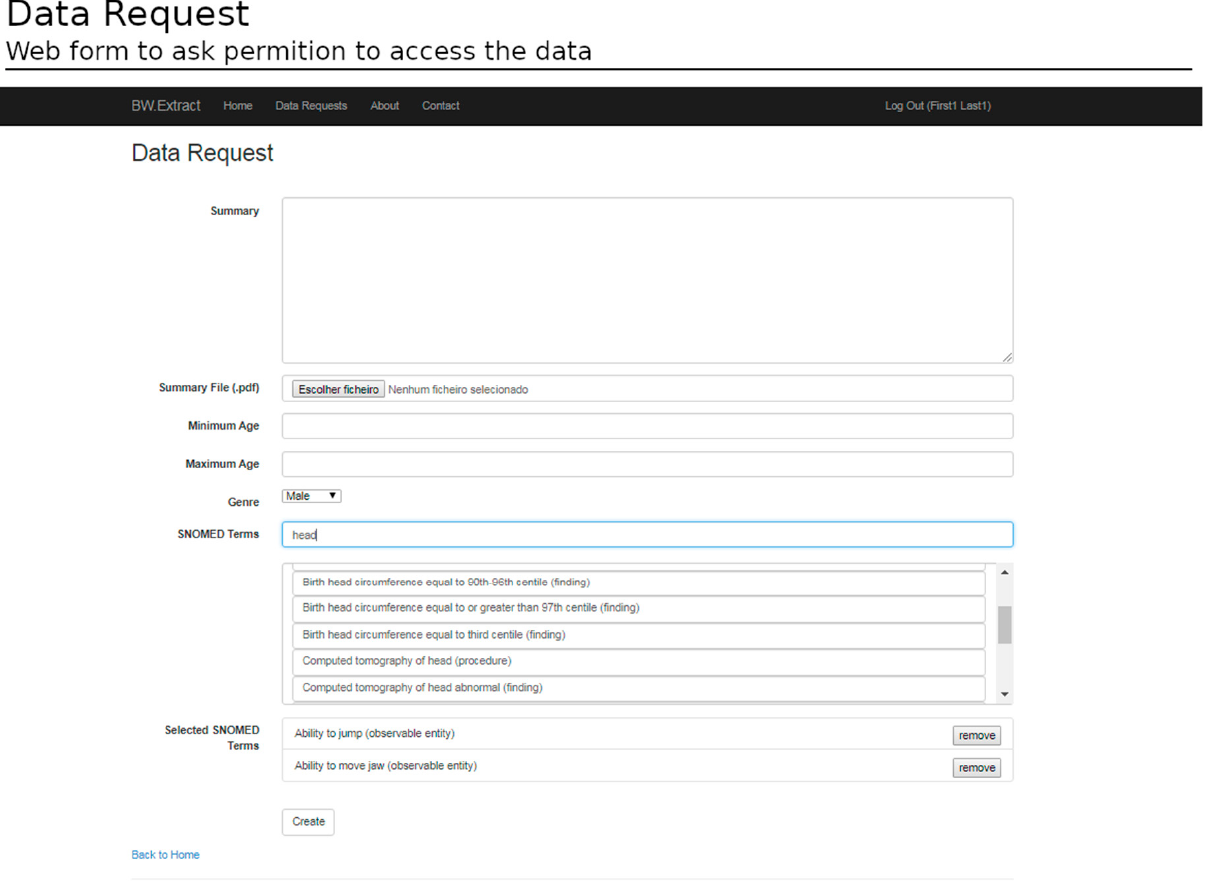
Figure 11. Web form for data requests. To ask for data, a researcher should provide a summary of the study and select data filters, such as the minimum and the maximum age, the genre, and the SNOMED CT concepts